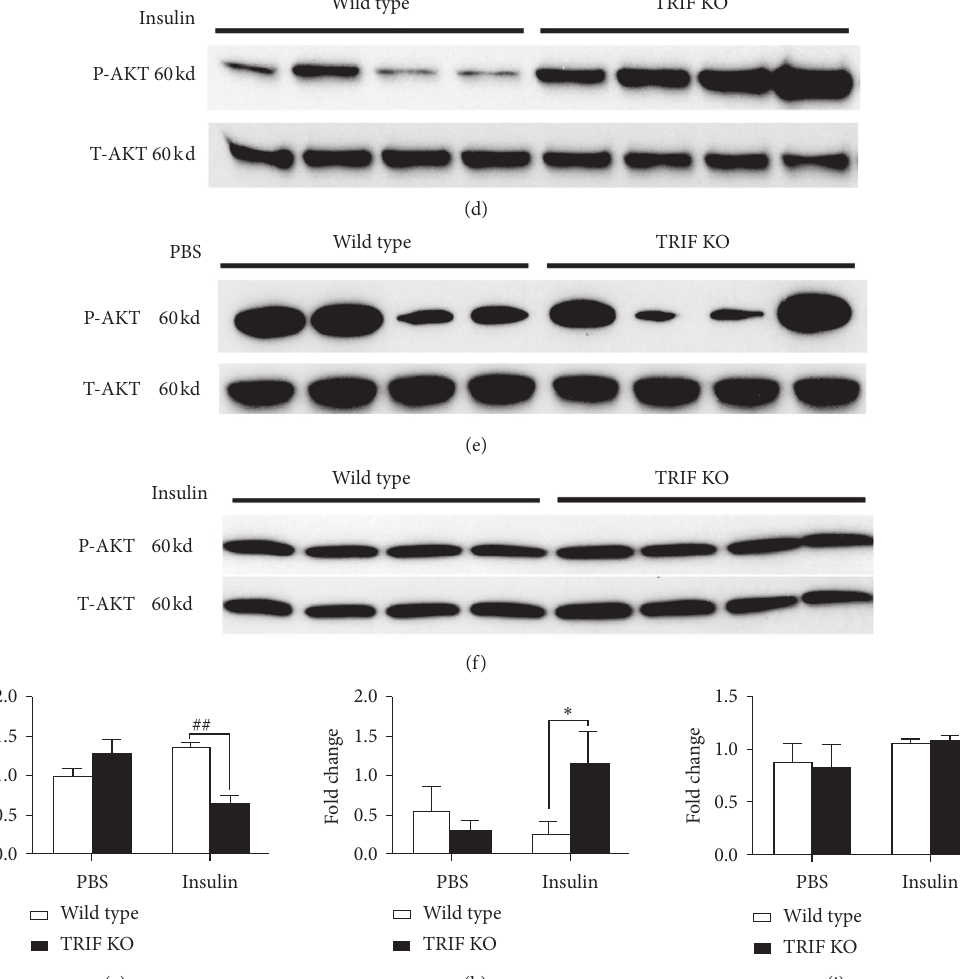
Figure 4: Effects of TRIF deficiency on activation of adipose tissue and liver AKT by insulin administration in mice. At 48 weeks of age, mice were fasted for 16h and then intraperitoneally administered with PBS (a, c, e) or insulin (5U/kg bodyweight) (b, d, f). Epididymal adipose tissue, muscle, and liver were collected 10 min after the administration. Levels of phospho-AKT (S473, P-Akt) and total-AKT (T-AKT) in adipose tissue (a, b), muscle (c, d), and liver (e, f) were determined by western blotting. (g–i) Bar graphs represent the results of den- sitometric analysis of western blots shown in (a) and (b), in (c) and (d), and in (e) and (f), respectively ( ∗ P < 0 . 05, ## P < 0 . 001) ( n �